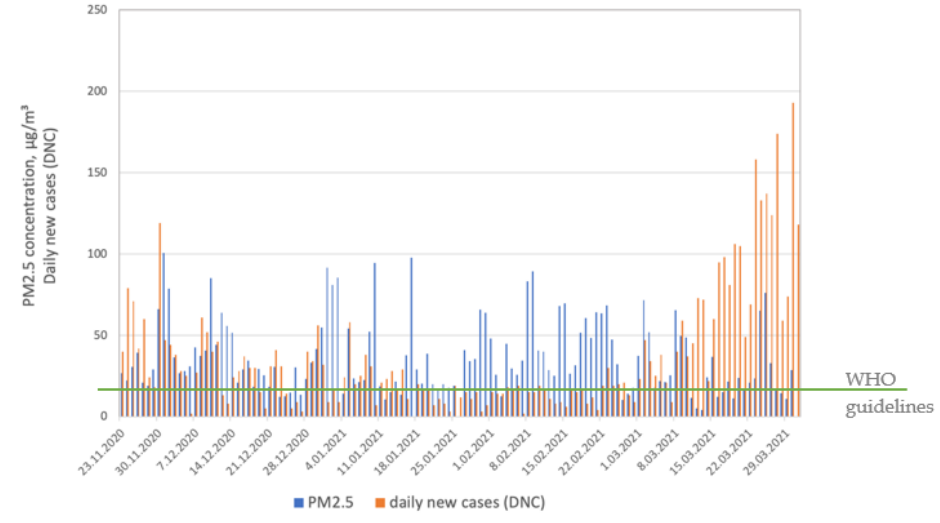
Figure 3. PM 2.5 concentrations and SARS-CoV-2 daily new cases (DNCs).